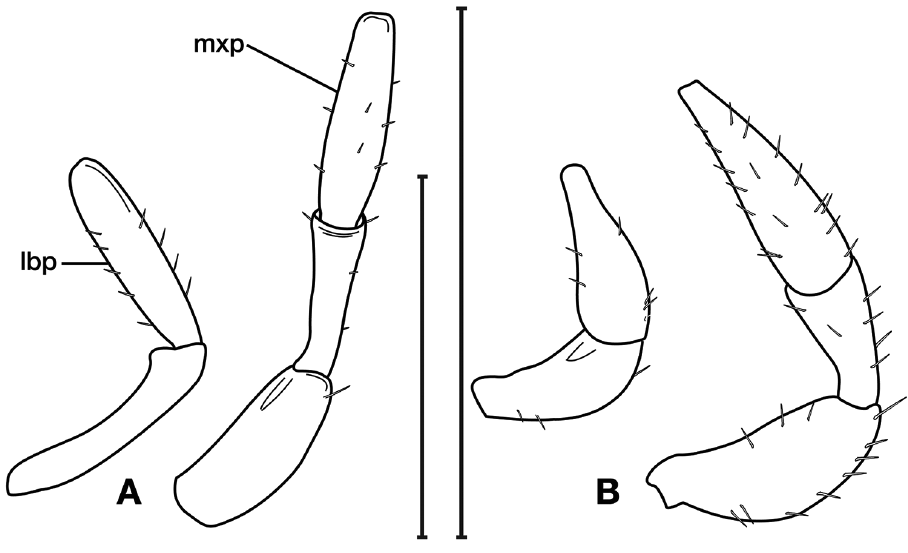
Figure 50. Line drawings comparing the form and setae pattern of labial ( lbp ) and maxillary palpi ( mxp ), right ventral aspect, of A C. ( Coptoderina ) occulta sp. n. and B Formosiella flavomaculata (Shibata). Scale bars: 0.5